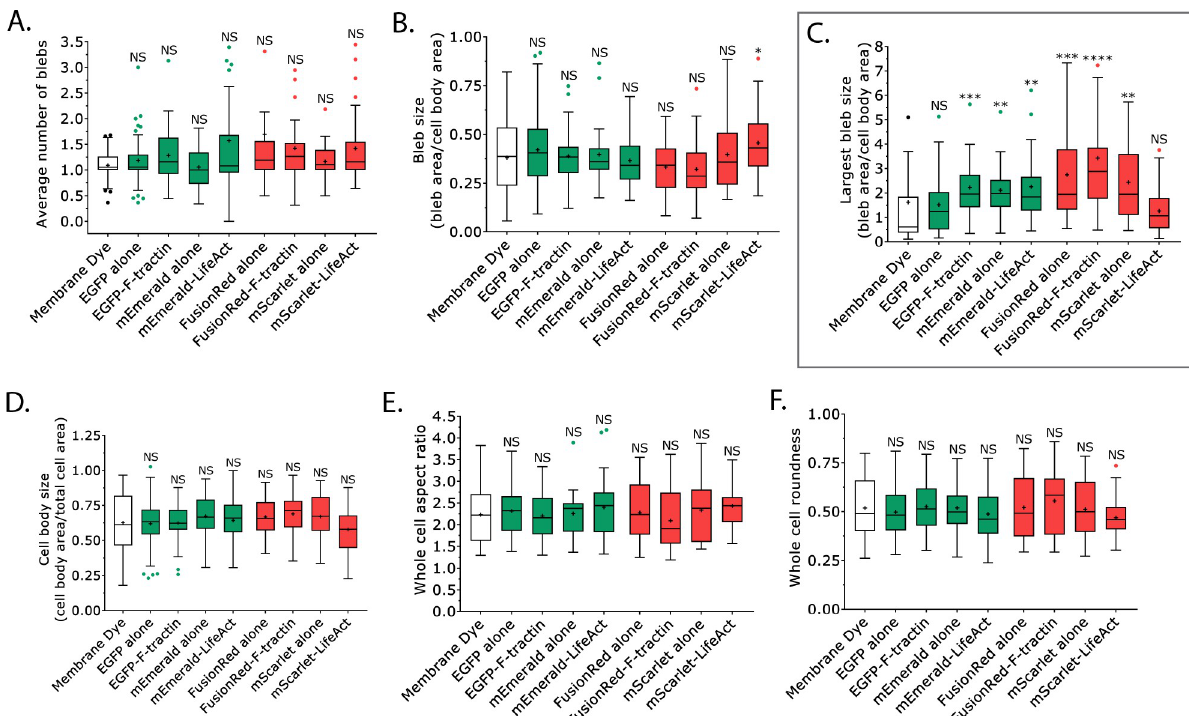
Fig 7. Cell morphometrics are affected by fluorescent protein markers. A-F. Using Analyze_Blebs, the average number of blebs ( A ), bleb size (all blebs; B ), largest bleb size ( C ), cell body size ( D ), whole cell aspect ratio ( E ), and whole cell roundness ( F ) was determined for melanoma A375-M2 cells stained with membrane dye (n = 35 cells), transiently transfected with EGFP alone (n = 82 cells), EGFP-F-tractin (n = 43 cells), mEmerald alone (n = 27 cells), mEmerald-LifeAct (n = 43 cells), FusionRed alone (n = 40 cells), FusionRed-F-tractin (n = 28 cells), mScarlet alone (n = 30 cells), or mScarlet-LifeAct (n = 51 cells) (“+” and line denote the mean and median, respectively). Statistical significance was determined using a One-way ANOVA and a Tukey’s post hoc test. All data are representative of at least three independent experiments. � —p � 0.05, �� —p � 0.01, ��� —p � 0.001, and ���� —p �